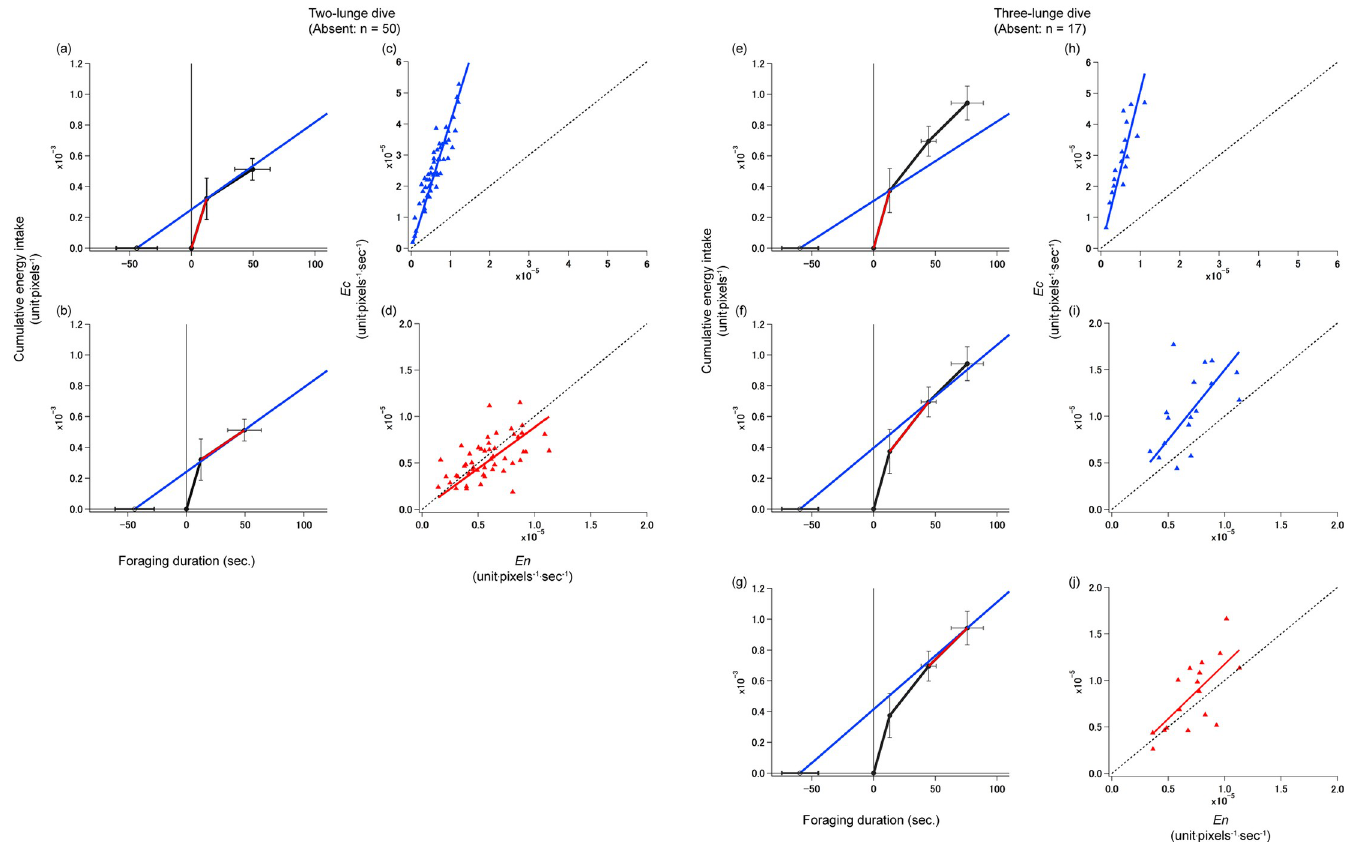
Fig 5. Foraging efficiency of lunges. Foraging models comparing the total rates of energy intake ( En ) and gain functions using mean values of dives with (ab) two- lunges (n = 50), (efg) three-lunges (n = 17). X-axis shows the foraging duration, composed of transit (descent + ascent) + post-surface + patch residence time. Y-axis shows cumulative energy intake. The total rate of energy intake ( En ) up to each lunge is represented by a blue line, and the rate of energy intake at each lunge ( Ec ) is indicated by a black or red line. Error bars on the black dots and the starting point of the blue line ( En ) represent the standard deviation of the mean values. A linear regression model of Ec versus En (cdhij) of the corresponding foraging model are shown on the right side of each foraging model. The dashed black line represents where Ec/En = 1. (c), (h), and (i) had Ec / En values greater than one (a; Ec / En = 4.1, 95% CI; 3.8–4.3: h; Ec / En = 5.1, 95% CI; 4.5–5.7: i; 1.5, 95% CI; 1.2–1.8). Although (j) also had Ec / En values greater than one the 95CI included Ec/En = 1 ( Ec / En = 1.2, 95% CI; 0.99–1.3). (d) had Ec / En values less than one ( Ec / En = 0.88, 95% CI; 0.75– 0.98).